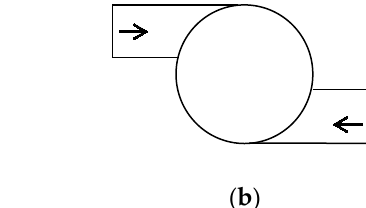
( c ) Figure 5. The gas velocity vector diagram without spray; ( a ) Single inlet; ( b ) Straight dual inlet; ( c ) Tan ‐ gential dual inlet. The gas velocity vector of the single inlet, straight dual inlet, and the tangential dual inlet with spray are shown in Figure 6. For the dual inlet tower, the flue gas velocity distribution is more uniform, and the phenomenon of flue gas rushing to the wall nearly disappears; on account of the strong interference of the downward spray droplets, two bigger gas flow whirlpools are formed on both sides of the inlet above the slurry surface, however, the whirlpools of the tangential inlet are smaller than those of the straight inlet, and as a result, the dual inlet design can reduce the possibility of byproduct depositing at the bottom of the inlet, and can enhance the stability of the system operation. In contrast, the dual inlet design only changes the entrance pattern of the flue gas, however, it makes progress toward a remarkably uniform distribution, which enhances heat transfer and avoids byproduct deposition on the bottom of the inlet.